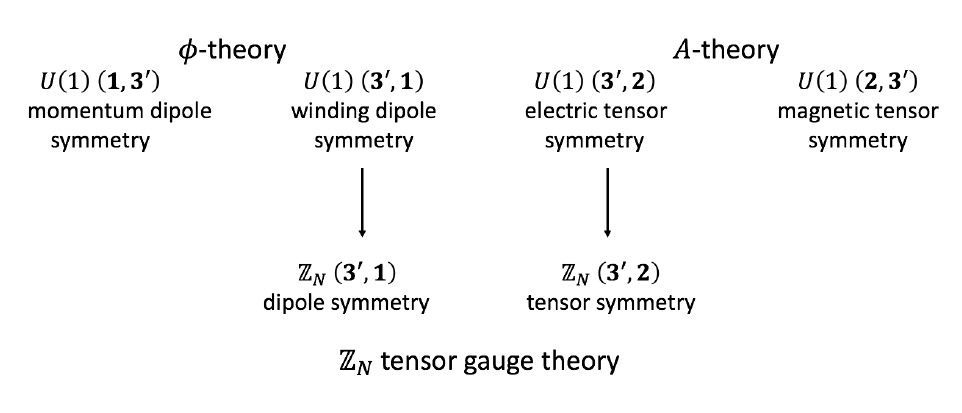
tensor N tensor gauge theory. The magnetic N tensor gauge theory because of N